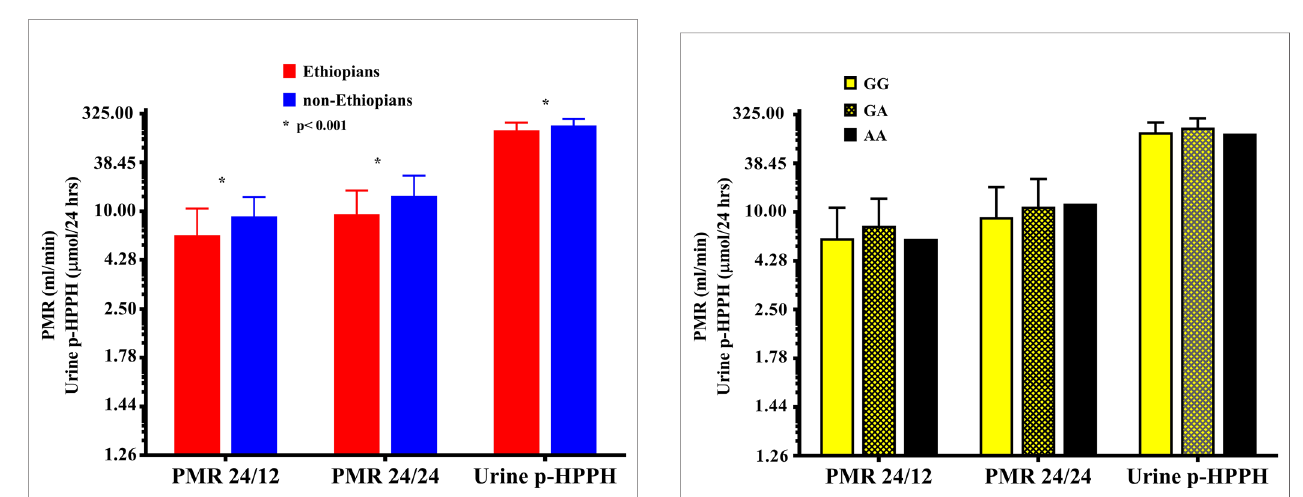
FIGURE 2 | The molar amount of p-HPPH in 24 urine collection, PMR24/12 and PMR24/24 among non-carriers of CYP2C9*2, *3, *5, *6, *8 , and *11 Ethiopian (red bars) and non-Ethiopian (blue bars) Jews. Log 10 transformed data was used for comparison with anti log 10 values presented on the y-axis. (Statistical comparison between Ethiopian and non-Ethiopian groups was performed by t -test on log 10 transformed data).